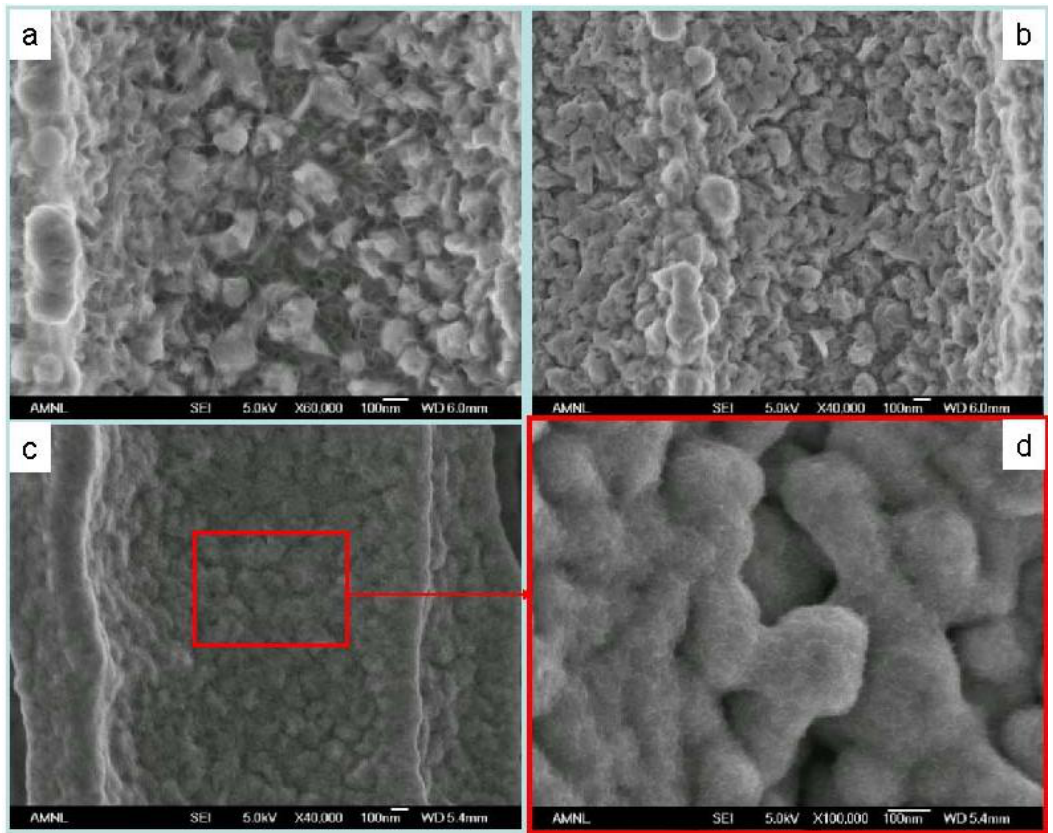
Figure 4. FESEM cross-sectional micrographs of the plated sidewalls at a depth of about 100 µm, taken from different samples with various degrees of treatment: (a) 1-h metallization stage; (b) 2-h metallization stage; (c) 8-h metallization stage; (d) Enlarged image of the aggregated Ni deposits.